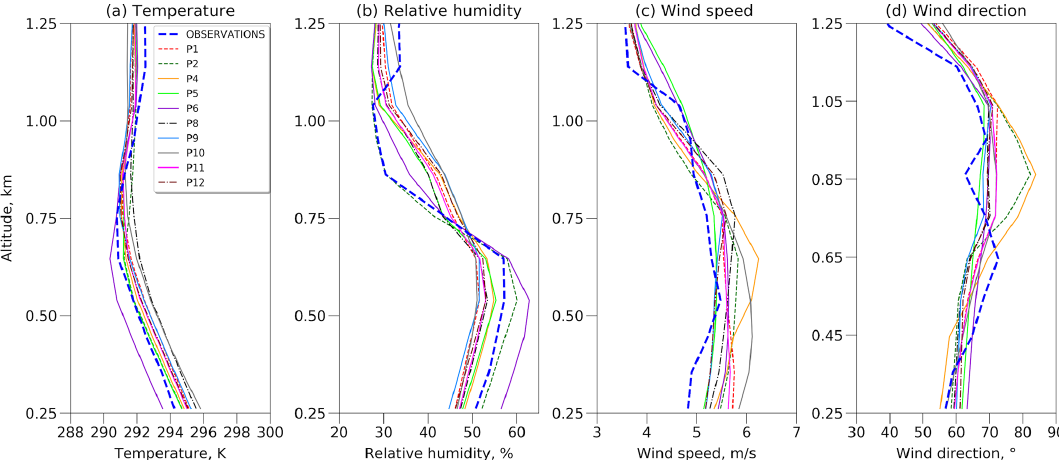
Figure 9. Vertical profile of meteorological parameters (thick blue line) observed by a radiosonde on 28 June 2019 below 1.25km altitude and WRF-Chem results for different boundary layer parameterizations (see Table